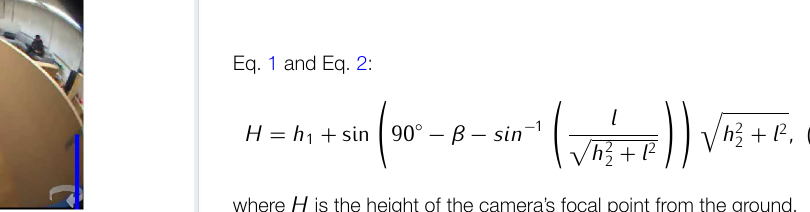
Figure 5. Giraff Camera Position